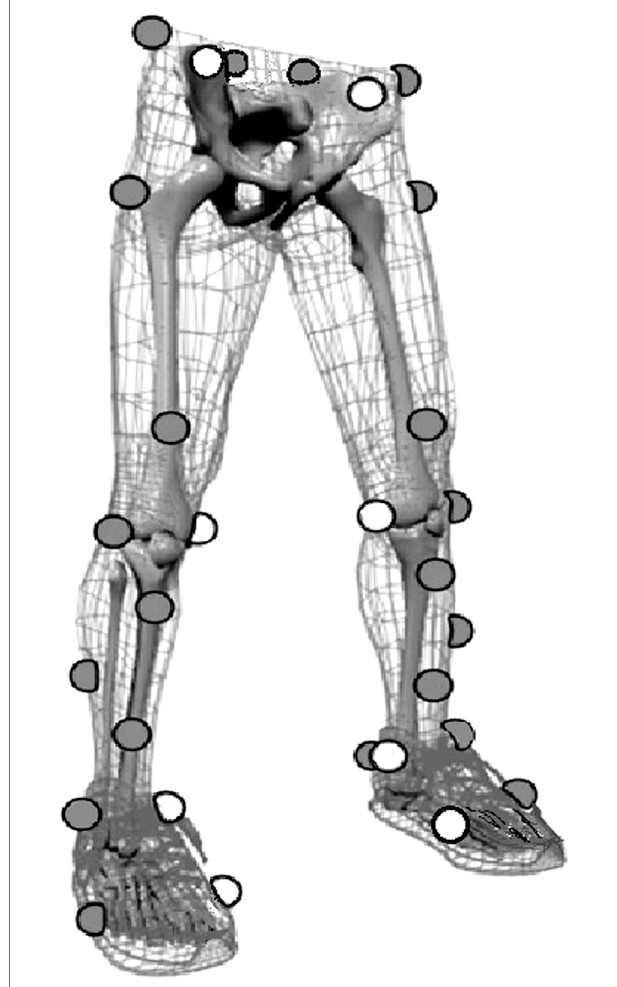
FIGURE 1 | Marker locations used to de fi ne the hip, knee, and ankle joints. The white markers, including the left and right anterior superior iliac spine, bilateral medial femoral condyle, bilateral medial malleoli, and bilateral fi fth metatarsal heads markers, were removed after static